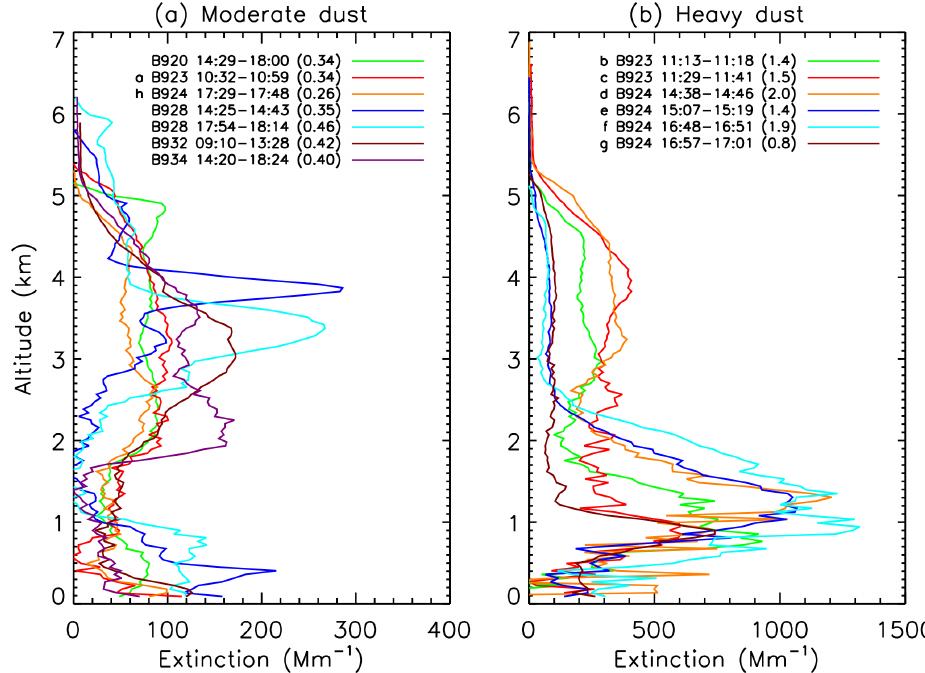
Figure 1. Vertical profiles of the aerosol extinction coefficient measured by airborne lidar, identified by flight number and time (UTC). The number in parentheses is the AOD resulting from the lidar profile. For flights B923 and B924, a letter (a–h) identifies the transects in Fig. 4 used to compute the profiles shown in this figure. Panel (a) refers to the moderate dust conditions, most often encountered during the campaign, whereas panel (b) refers to the heavy dust loads encountered on 12